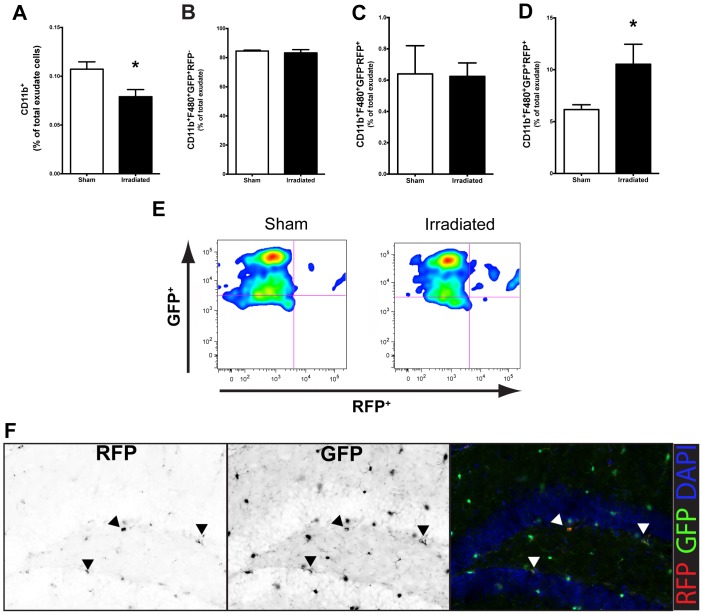
Cranial irradiation induces the infiltration of peripherally derived macrophages at seven days.
A. The percentage of CD11b+GFP+ microglial cells was significantly decreased in CCR2RFP/+CX3CR1GFP/+ irradiated mice compared to sham (Student’s t-Test; *p<0.05). B. Cranial irradiation does not affect the percentage of resident macrophages (CD11b+F4/80+CX3CR1+CCR2−, Student’s t-Test; p>0.05), C. nor the proportion of peripheral macrophages (CD11b+F4/80+CX3CR1−CCR2+, Student’s t-Test; p>0.05); D. but is associated with a significant increase in the percentage of infiltrated peripherally derived cells that had differentiated into microglia-like macrophages (CD11b+F4/80+CX3CR1+CCR2+, Student’s t-Test; *p<0.05). E. Representative plots showing the radiation-induced accumulation of peripherally derived macrophages into the brain parenchyma. F. Moreover, these cells can be seen in the dentate gyrus of the dorsal hippocampal formation following irradiation. RFP and GFP single pseudo-colored image is converted to black and white to discriminate location in the color co-localized panel. Black arrowheads point to individual positively labeled cells for their respective fluorchrome, while white arrowheads show the colocalized cells in the pseudo-colored image.